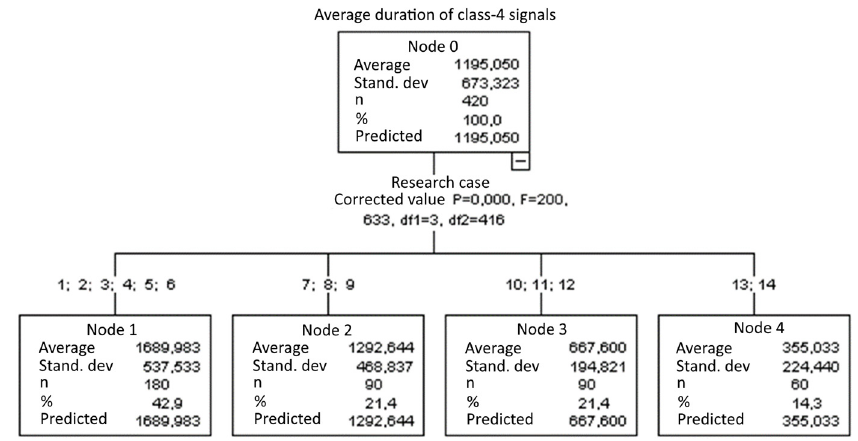
Figure 27. Classification tree for the average duration of class-4 signals.